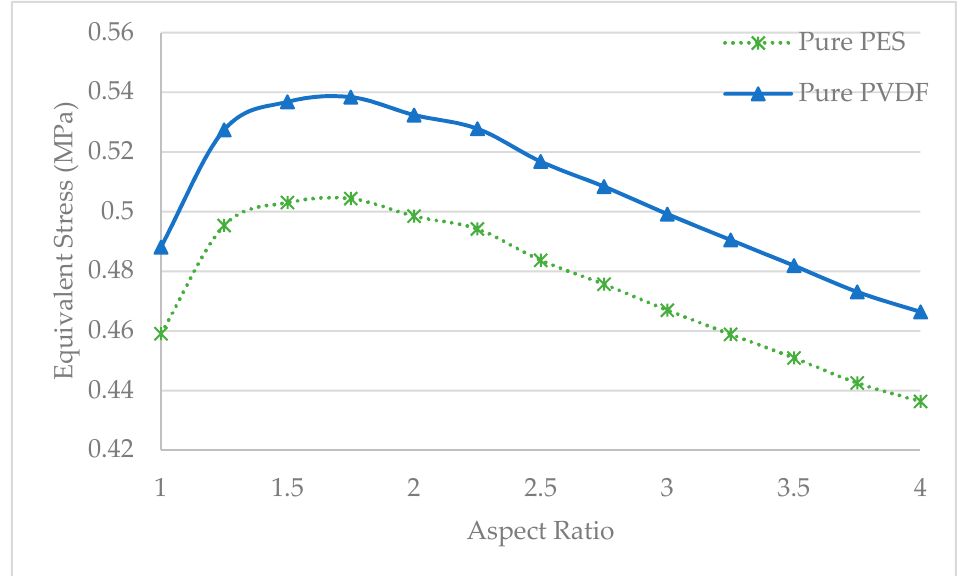
Figure 14. Maximum equivalent stresses of pure membranes of different aspect ratios. In Figure 15, it is shown that there is an inverse correlation between the aspect ratio and the maximum displacement value. Hence, the lowest maximum displacement value is obtained in elliptical membranes with the highest aspect ratio (a/b = 4). Because of the stiffer nature of the PVDF membrane, fewer displacement values are observed. In Figure 16, the maximum in-plane principal strain values of pure membranes with different aspect ratios are given. It can be claimed that the in-plane principal strain values of pure PVDF membranes are less than the pure PES membranes, similar to the displacement results. Even though the displacement value fell with increasing aspect ratios, the strain values